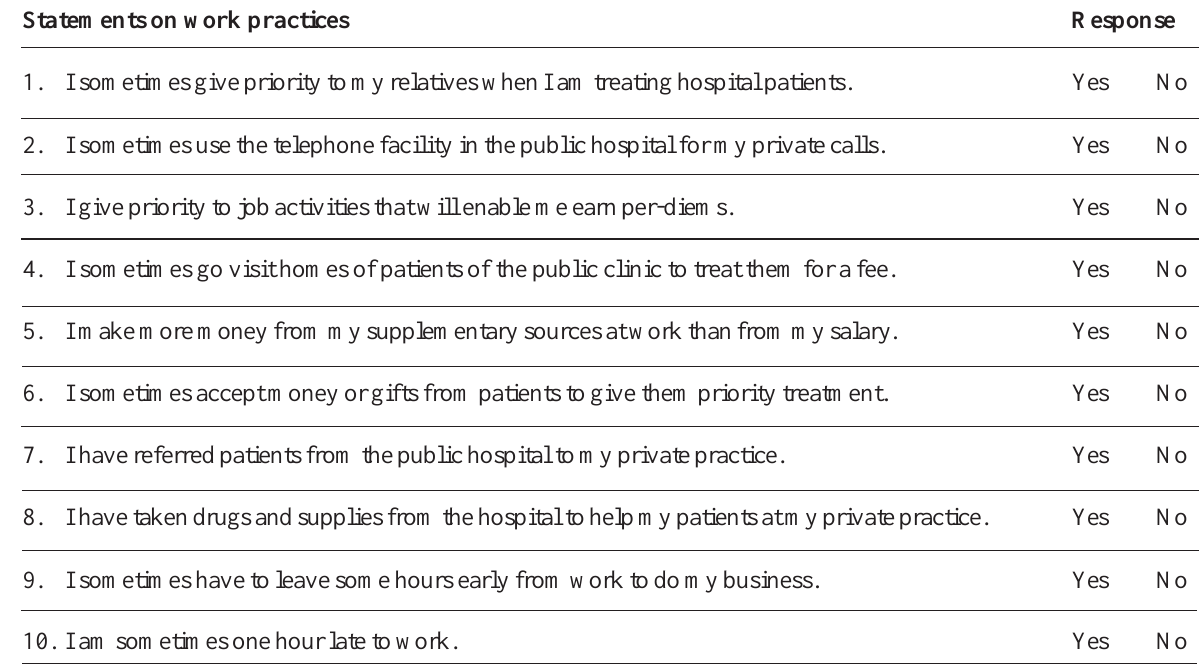
behaviours of health care